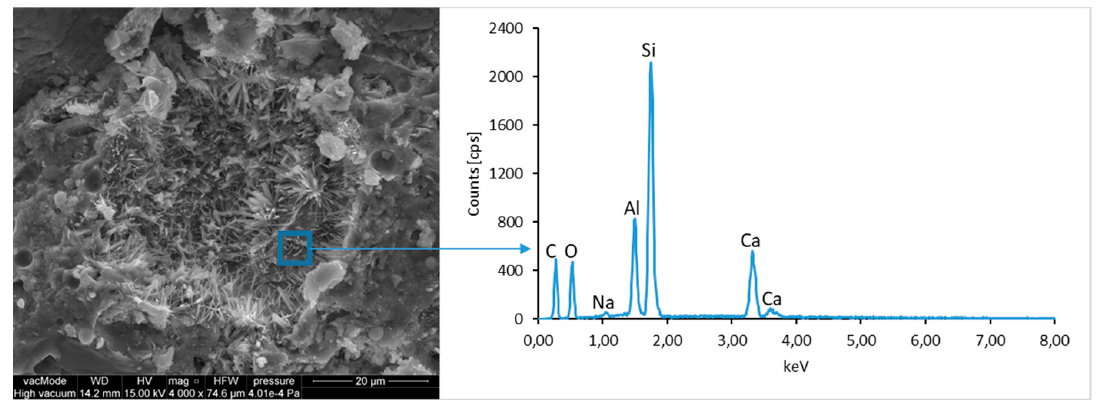
Figure 18. SEM micro-structure of CI.0 concrete and results of elemental analysis in EDS micro-area— fibrous structure of C–S–H is visible in the